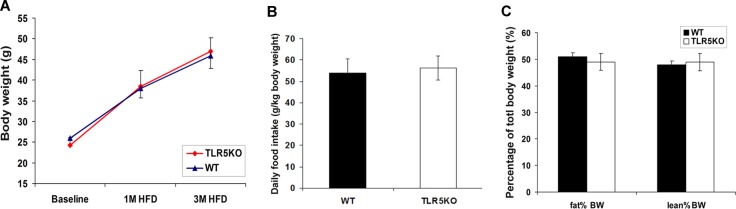
Body weight, food intake and body mass composition in wild type (WT) and TLR5 knockout (TLR5KO) mice fed a high fat diet.A: mice were fed with 12 weeks of high fat diet starting at 8 weeks of age (n = 20 per group). Body weight was monitored as indicated. B: Mice were individually caged and adapted for one week. Food intake (HFD) was measured manually every other day for a total period of 10 days. Daily food intake was calculated from data collected for a period of 10 days (n = 6 per group). C: Body fat mass and lean mass of HFD-fed mice was measured by quantitative magnetic resonance (QMR) (n = 8 per group).